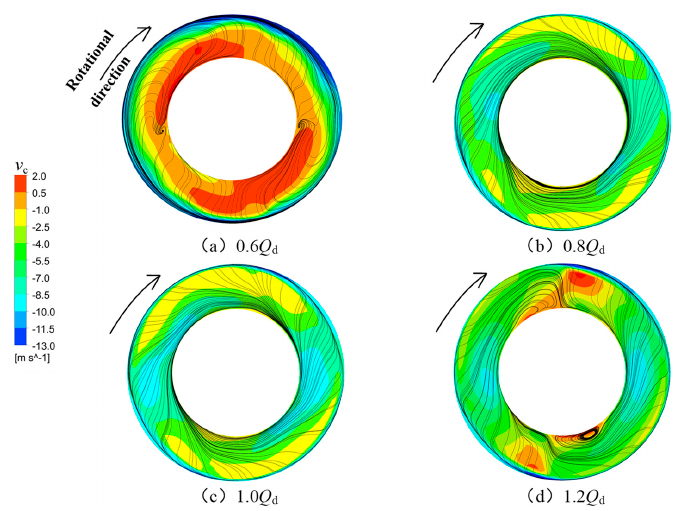
Figure 7. Circumferential velocity distribution of the inlet for the second-stage impeller under di ff erent fl ow rates.